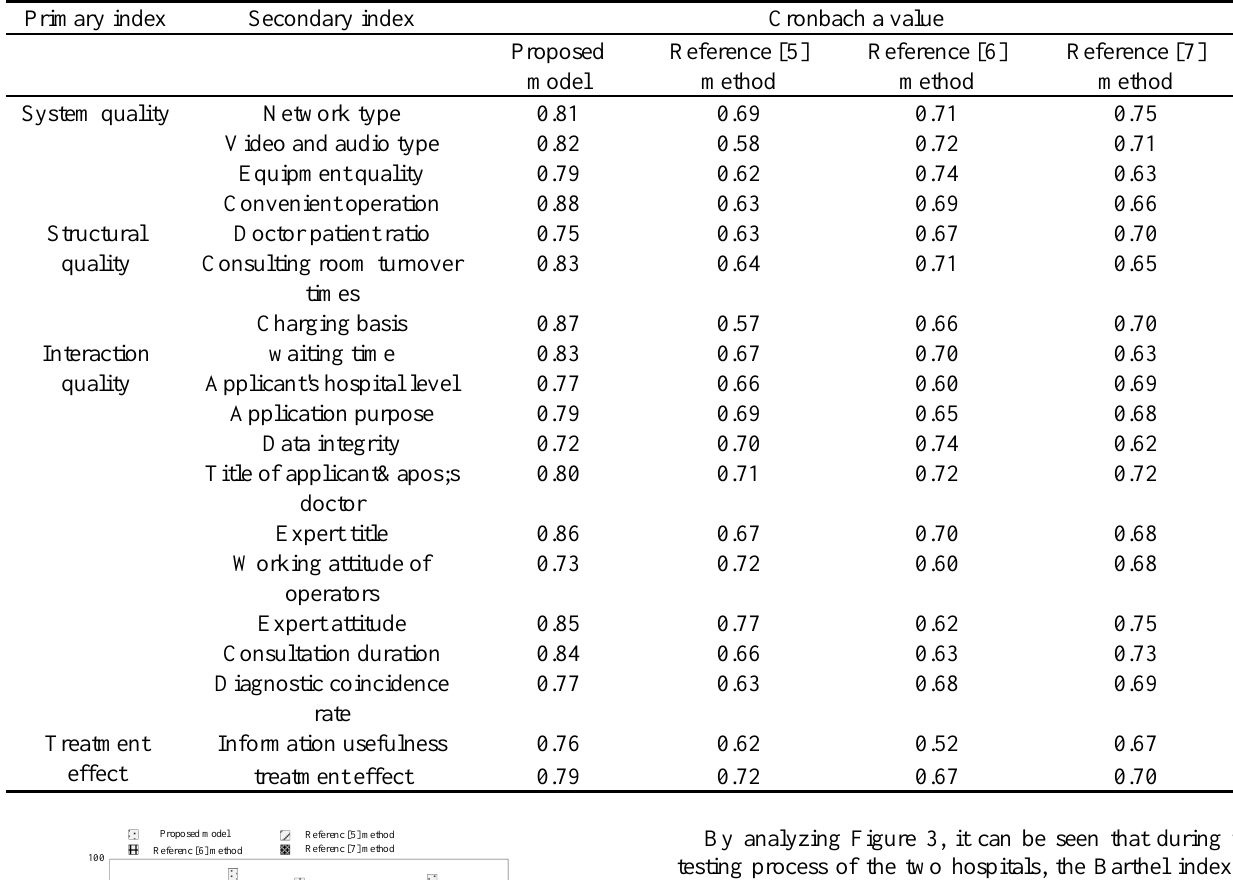
By analyzing Figure 3, it can be seen that during the testing process of the two hospitals, the Barthel index of the proposed method is higher than that of the methods in reference [5], reference [6] and reference [7], indicating that the accuracy of the evaluation results obtained by the proposed method in evaluating the quality of telemedicine service is high. The proposed method and the methods of reference [5], reference [6] and reference [7] are used to evaluate the quality of telemedicine service, and the satisfaction of different users with the evaluation results is compared. The test results are shown in Figure 5.